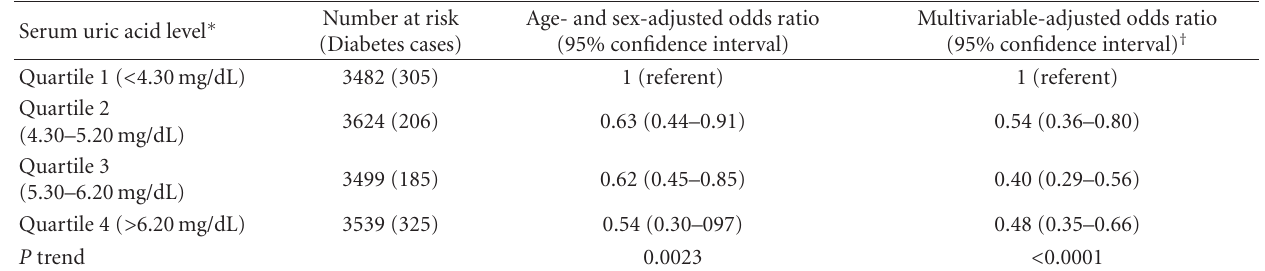
Table 2: Association between serum uric acid level and diabetes